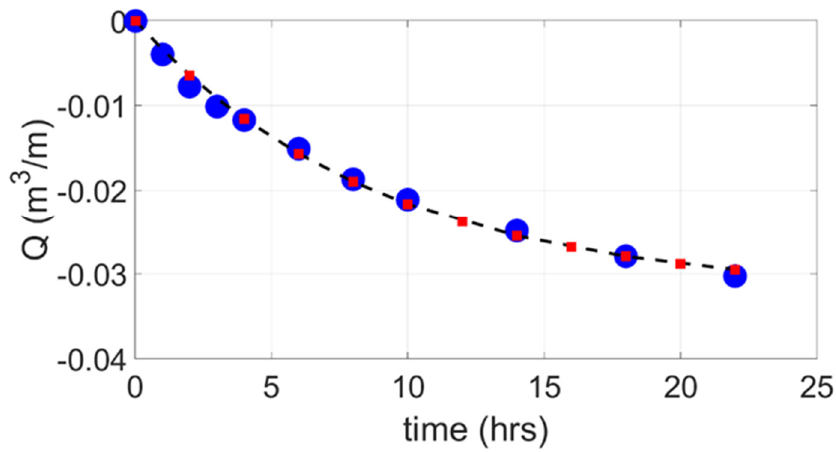
Figure 7. Cumulative net bulk sediment transport, Q, versus time for data (dots) and equilibrium model. For modelling purposes, the transport Q is first fitted to the exponential-based law Q eq (1 − exp(−t/τ)), with Q eq = −0.03 m 3 /m and τ = 9 h, and discretised with dt = 2 h.